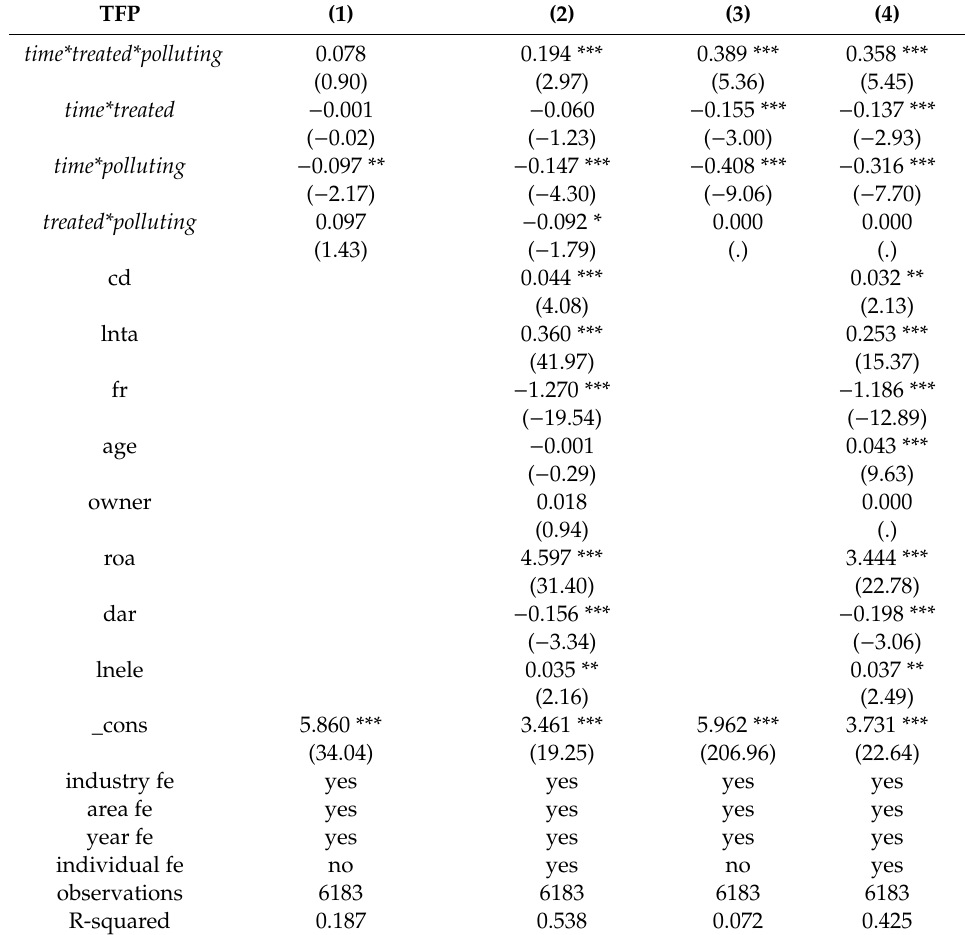
Table 5. Estimation results of di ff erences-in-di ff erences-in-di ff erences (DDD) model. TFP